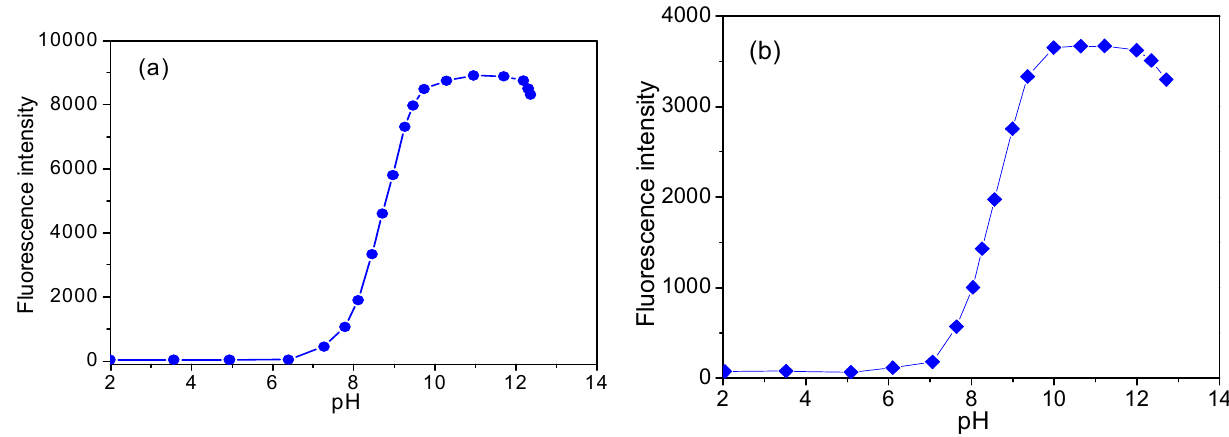
Figure 8. Fluorescence spectra of CH ( a , c ) and ECH ( b , d ) aqueous solutions with various pH. c CH = 0.407 μ g·mL − 1 , c ECH = 0.204 μ g·mL − 1 , MeOH 10%, λ ex / λ em : 279 nm/410 nm. Figure 9 shows the relationship between fluorescence intensity and pH values of the CH and ECH aqueous solutions. These two curves are nearly the same. When pH > 6.0, there is an increase of fluorescence intensity due to the transformation of CH + to CHOH. When pH > 12.0, the decrease in fluorescence intensity is probably due to the proton ionization of the 6-hydroxyl group of CHOH. CHOH does not participate in the conjugate plane of the molecule, and its proton ionization has almost no effect on the fluorescence wavelength and only a slight effect on the fluorescence intensity.